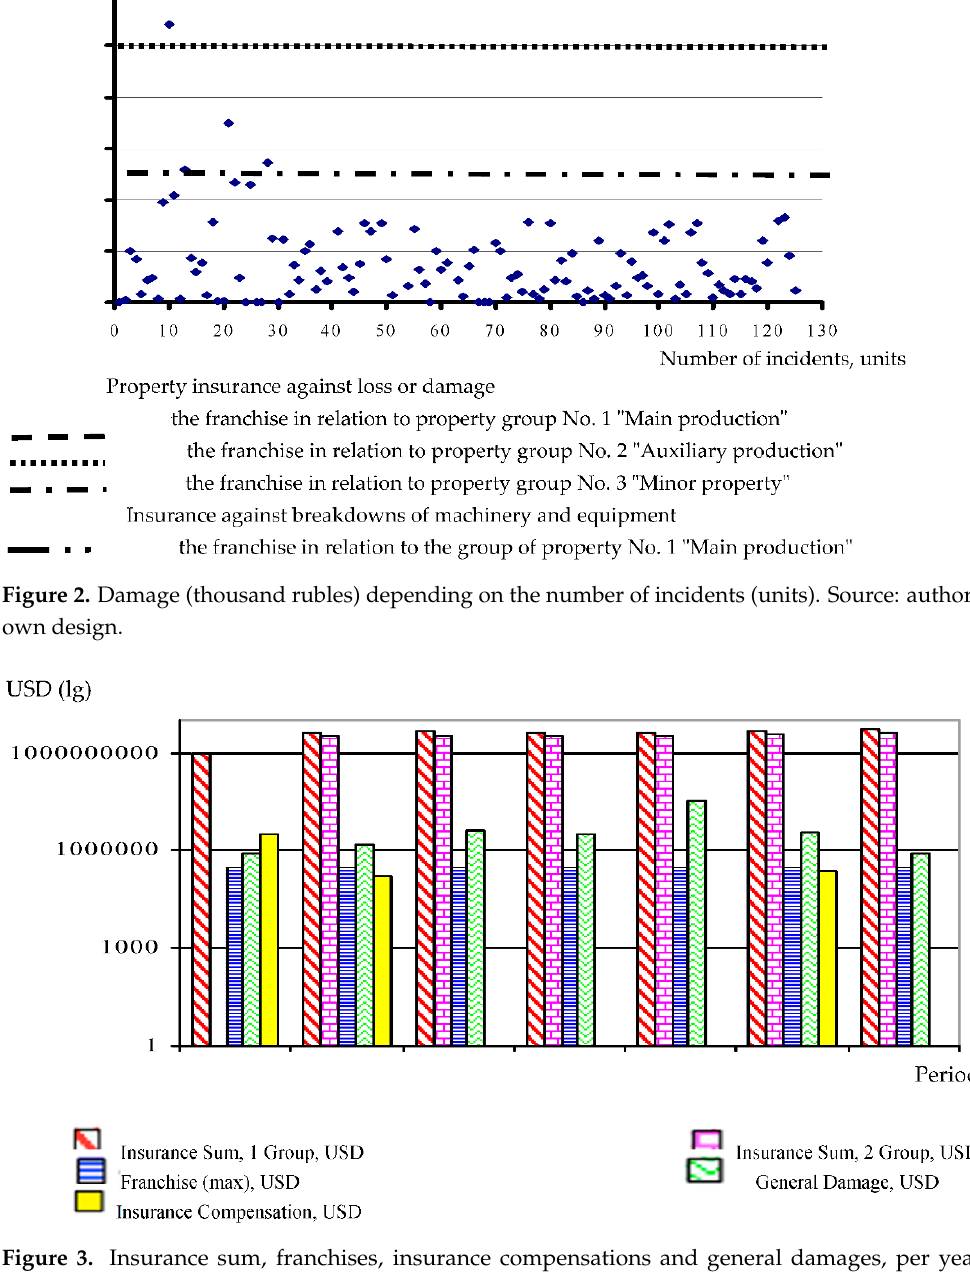
Figure 3. Insurance sum, franchises, insurance compensations and general damages, per year (logarithmic scale), thousand rubles. Source: authors own design.